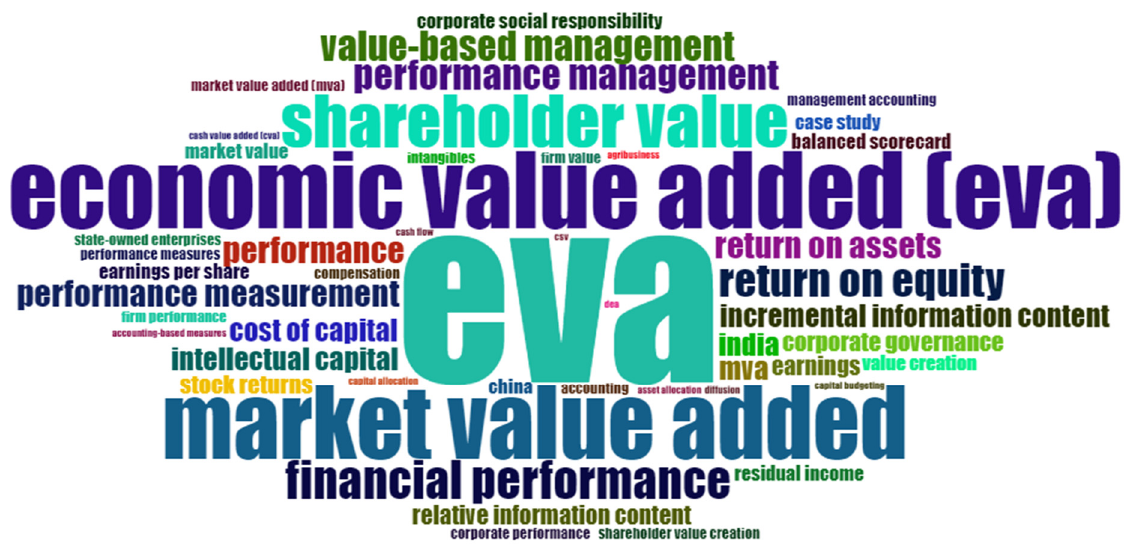
Figure 11. Word map of author’s keywords in EVA research (Biblioshiny).